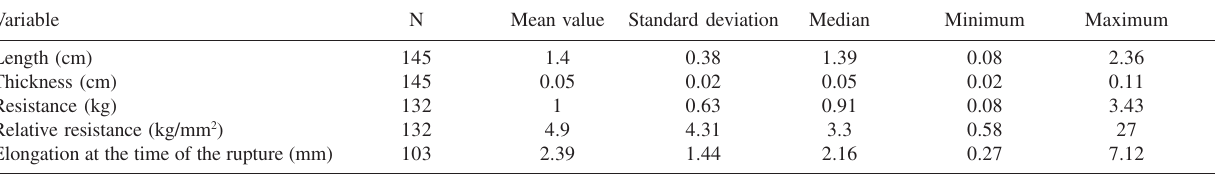
Table 1 - Mean values, standard deviation, median, minimum, and maximum measurements performed on the chordae tendineae Variable